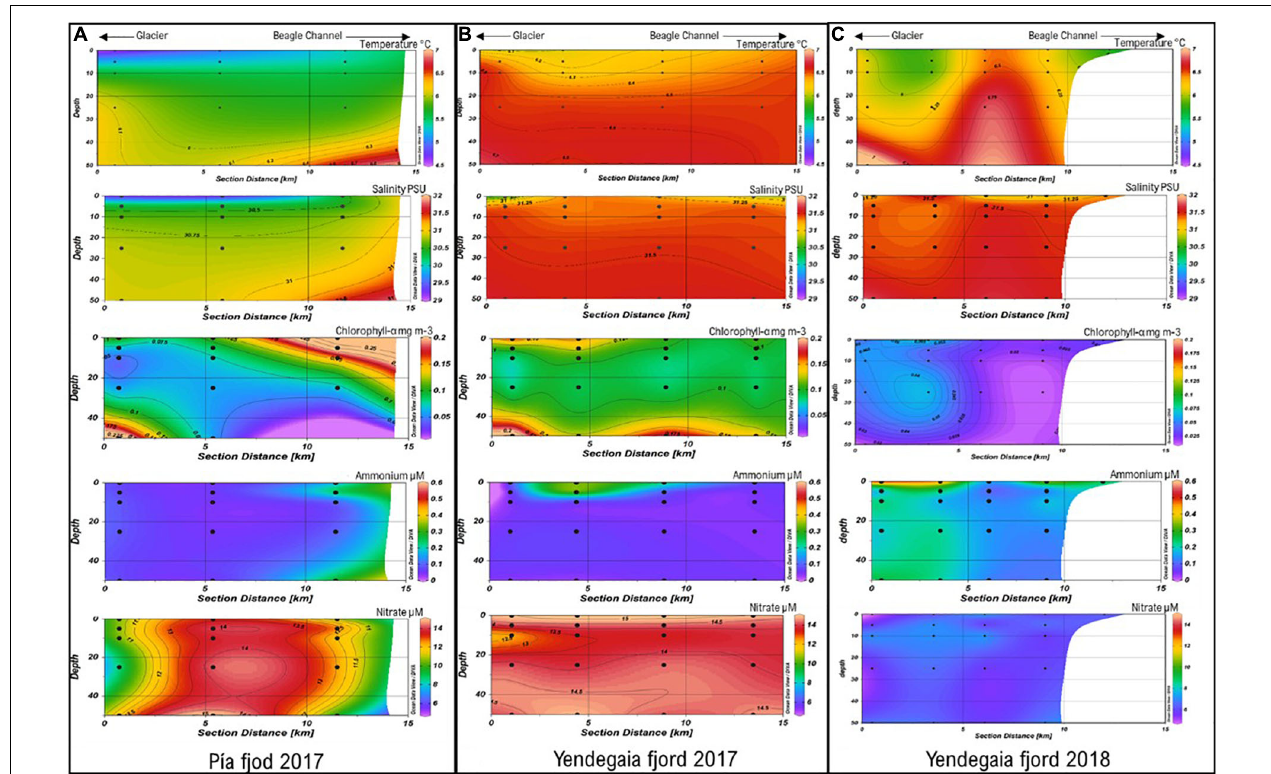
FIGURE 2 | Temperature, salinity, chlorophyll a, ammonium and nitrate concentrations in the (A) Pia fjord July 2017 and Yendegaia fjord July 2017 (B) and July 2018 (C) from the head (glacier) to mouth (Beagle Channel) stations and across